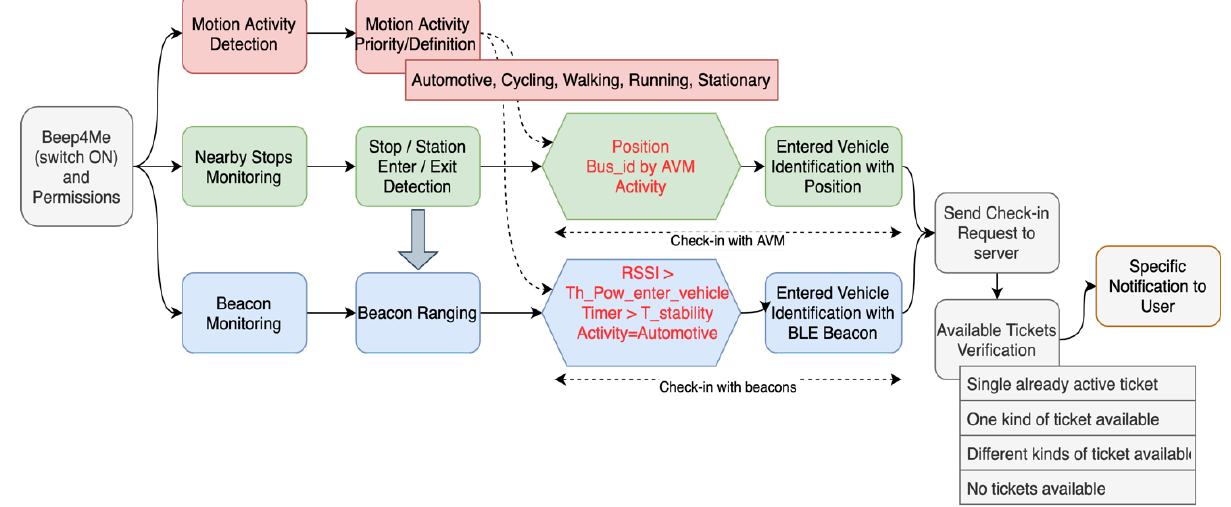
Figure 4. Flow diagram of the automatic check-in operations.